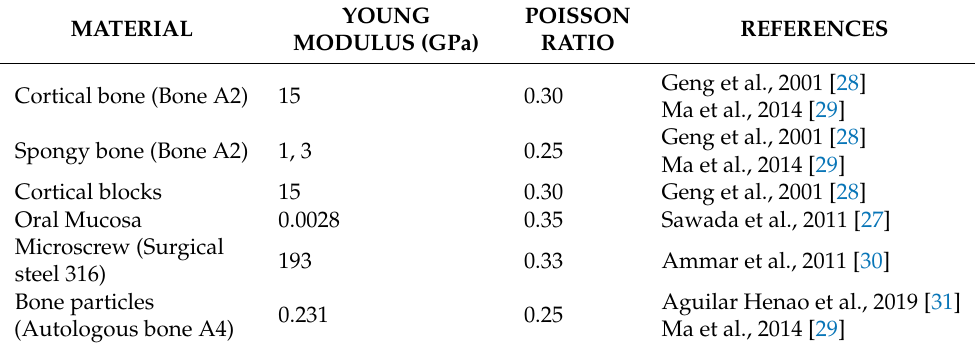
Table 1. Young Modulus and Poisson Ratios of each of the elements